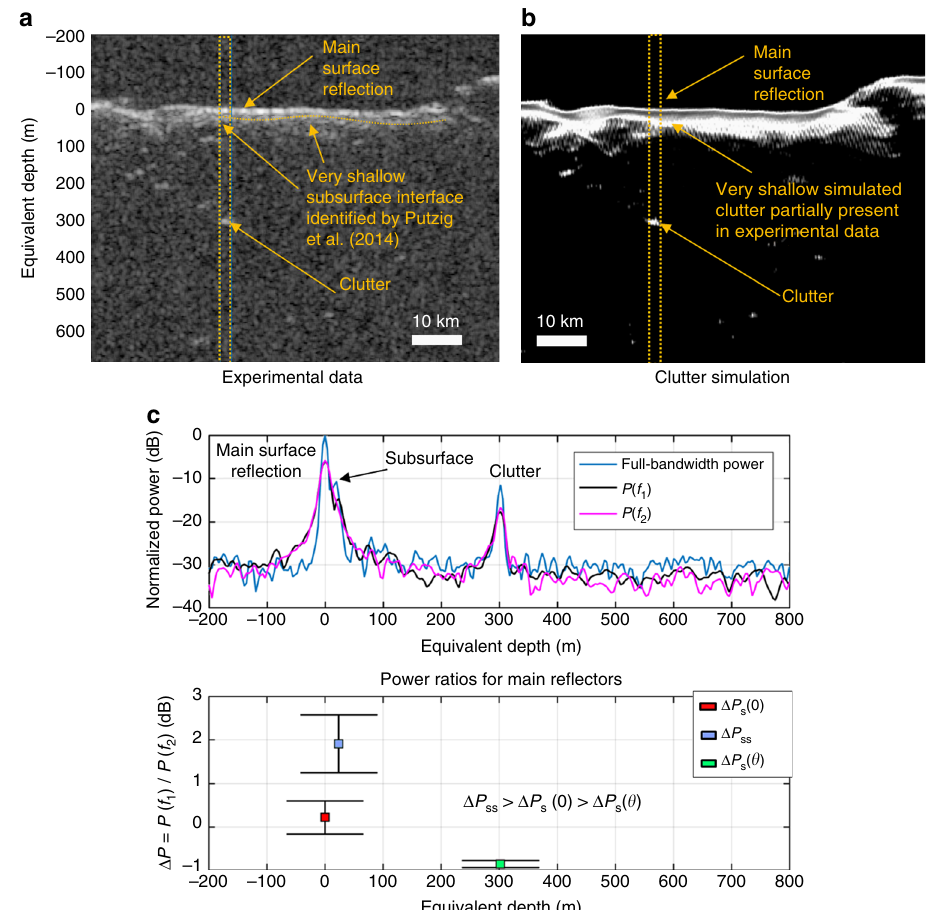
Fig. 10 Example of clutter and signal detection at the Phoenix landing site in the Northern Plains of Mars. Example of the bio-inspired model results for a portion of the SHARAD radargram 1290301. This radargram has been previously analyzed by Putzig et al. 38 and it is acquired over the Green Valley of Vastitas Borealis and contains both clutter and subsurface features. The disambiguation condition Δ P ss (0, z ) > Δ P s (0) ≥ Δ P s ( θ ) is veri fi ed allowing the discrimination of clutter to be accurately performed and con fi rming the presence of a very shallow subsurface interface below the Phoenix landing site region. a SHARAD radargram 1290301. The dashed orange box is the region under investigation. The dashed orange line highlights a very shallow subsurface re fl ection mapped by Putzig et al. 38 using the same SHARAD observation. b In this case, clutter simulation highlights a clear clutter re fl ection at about 300 m depths but overestimates clutter in the shallow subsurface. c Echo traces (average over the investigated region) for the full and split bandwidth SHARAD signal (upper plot) and mean and standard deviation of power ratios for main re fl ectors (lower plot). The number of echo traces considered for deriving the statistics is equal to 400. The equivalent depth in the subsurface medium is computed from time delay assuming ε =